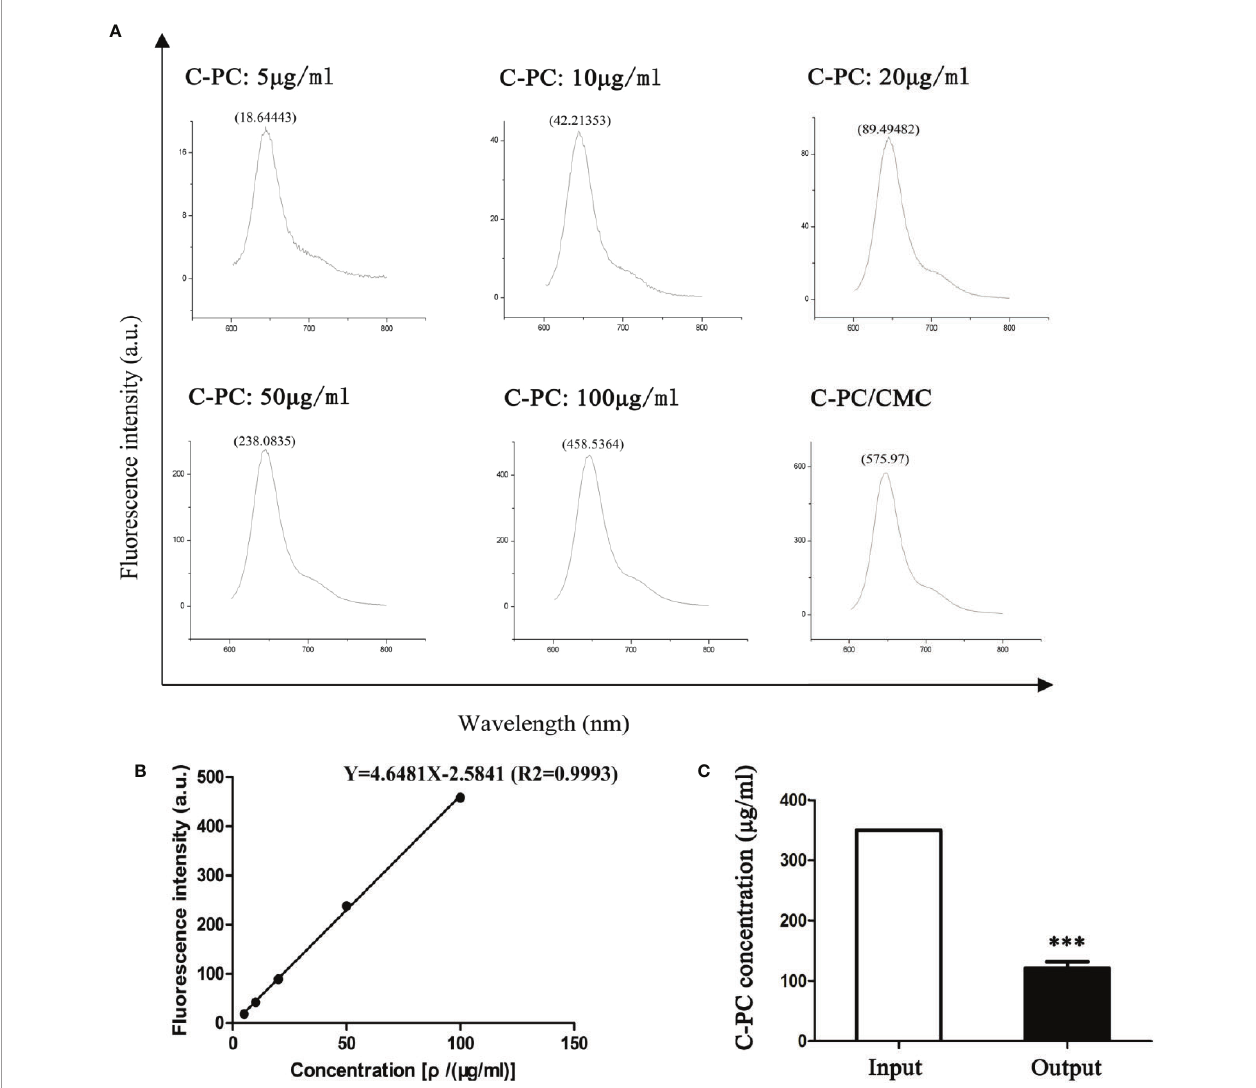
FIGURE 1 | Encapsulation Ef fi ciency (EE) and Loading Ef fi ciency (LE) of C-Phycocyanin (C-PC)/Carboxymethyl Chitosan (CMC) nanospheres. (A) Fluorescence spectrophotometry assay. The horizontal axis represents the wavelength (nm) and the vertical axis represents the fl uorescence intensity (a.u.). The fl uorescence intensity in response to 5, 10, 20, 50, and 100 m g/ml C-PC at 644 nm was 18.64443, 42.21353, 89.49482, 238.0835, and 458.5364, respectively. The fl uorescence intensity of the supernatant of the C-PC/CMC solution was 575.97. (B) Standard curve. The horizontal axis represents the concentration [ r /( m g/ml)] and the vertical axis represents the fl uorescence intensity (a.u.). The concentration was linearly related to the fl uorescence intensity, and the standard curve was used to determine the concentration of the supernatant of the C-PC/CMC solution. (C) Supernatant analysis. The initial concentration of C-PC was used as the input, and the concentration of the supernatant of the C-PC/CMC solution was the output. Results are expressed as the mean ± SEM (n = 3). ***P <